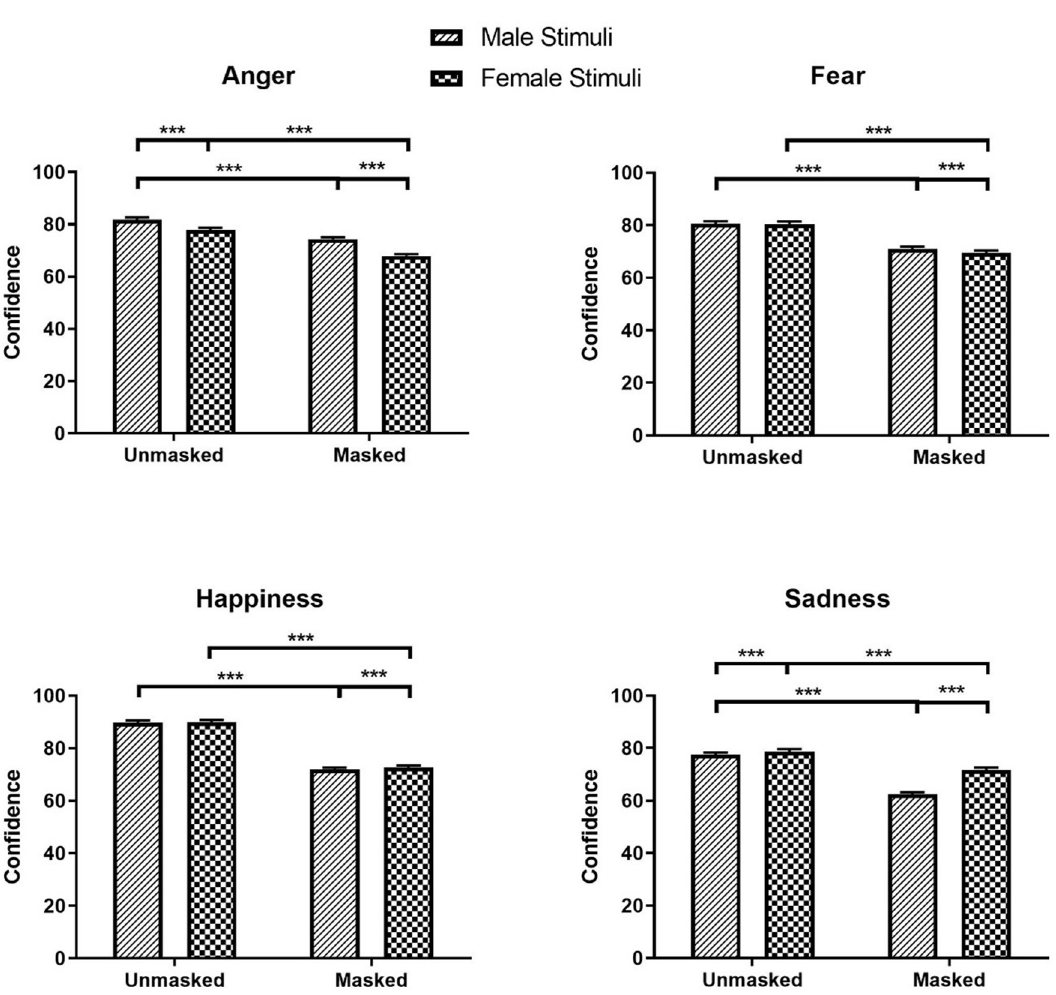
Fig 2. Confidence ratings for anger, fear, happiness, and sadness as a function of mask and stimuli sex. � p < 0.05, �� p < 0.01, ��� p < 0.001.